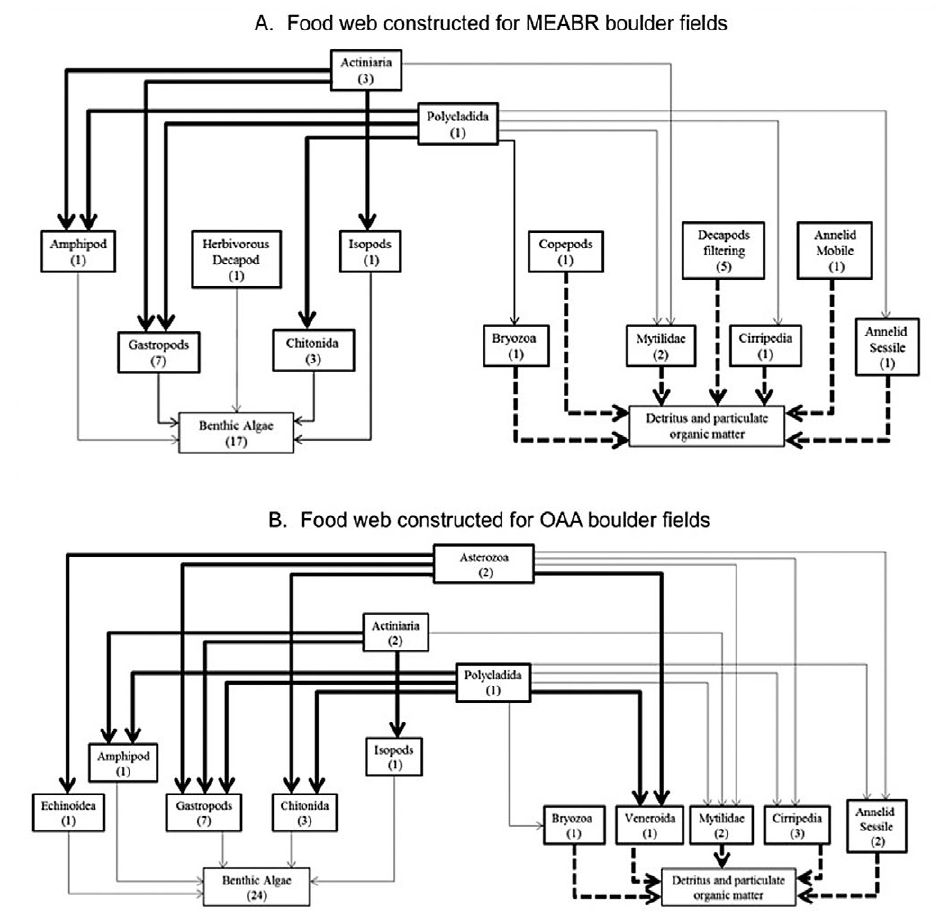
Fig. 3. – Food web constructed for (A) MEABR and (B) OAA boulder fields. Numbers within each box represent the quantity of individuals recorded for each species. Bolded lines indicate predation on mobile organisms. Unbolded lines indicate predation on sessile organisms. Dotted lines represent filtering